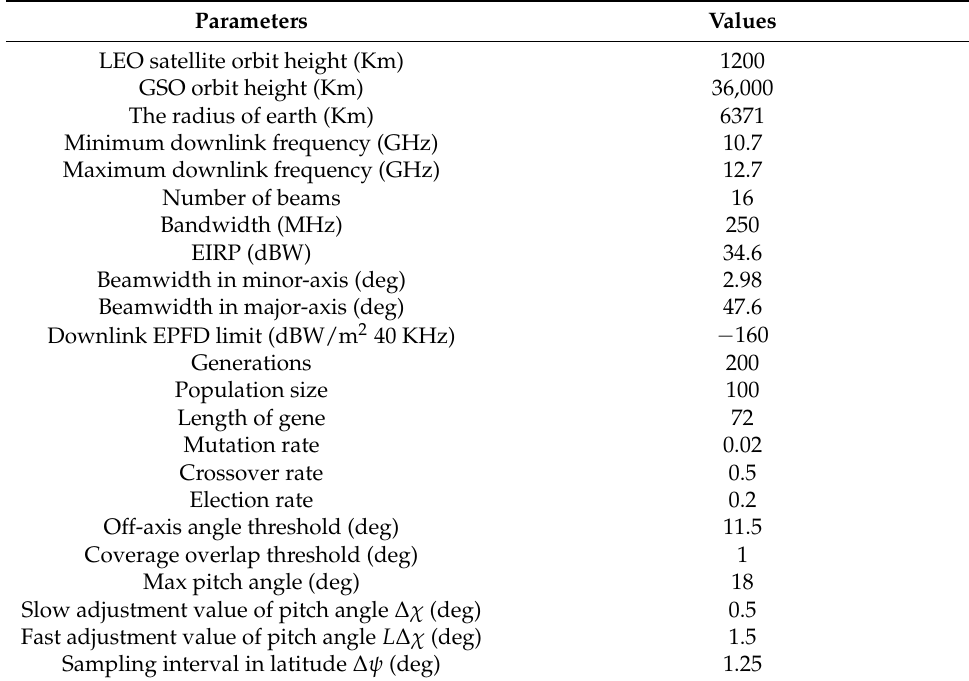
Table 2. Parameters of genetic